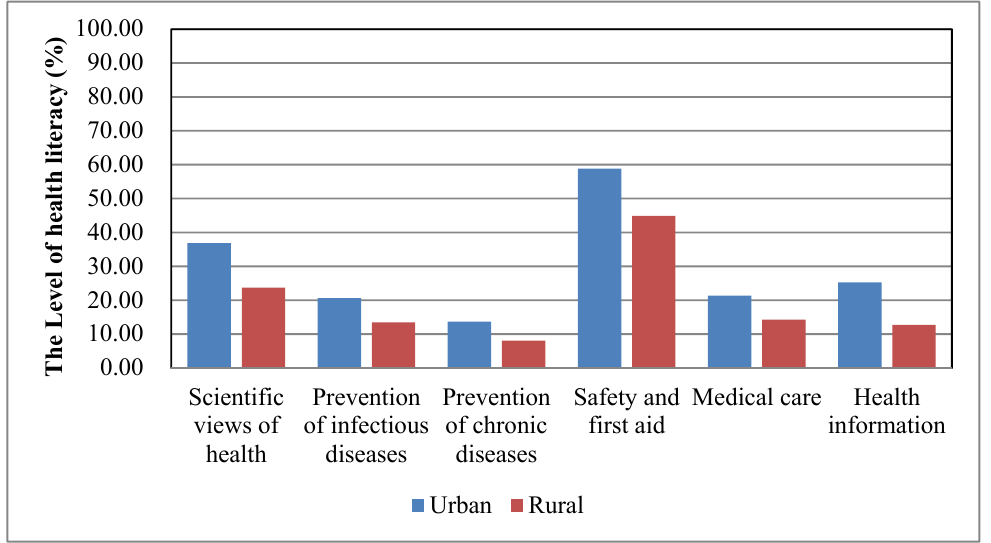
Figure 4. The level of health literacy in 6 types of health problems: scientific views of health, prevention of infectious diseases, prevention of chronic diseases, safety and first aid, medical care, and health information.